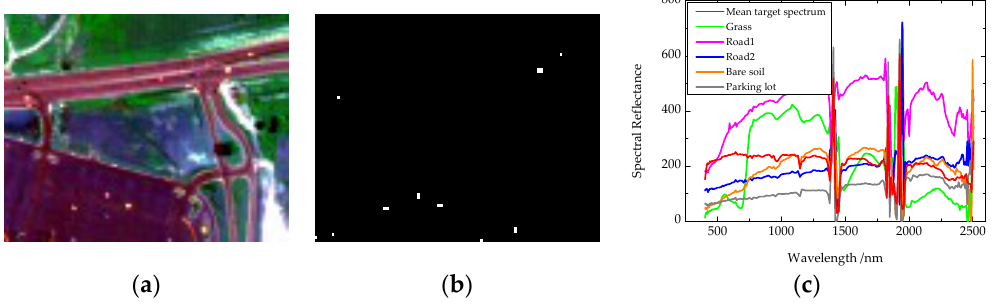
Figure 4. HYDICE urban dataset for the experiment. ( a ) Image scene; ( b ) The true locations of the targets; ( c ) Spectra of mean target pixels and some representative background samples.